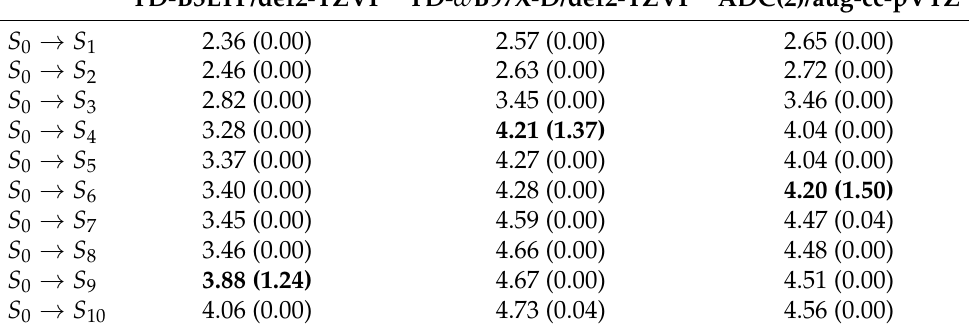
Table 3. Vertical excitation energies in eV and oscillator strengths (in parentheses) of the lowest ten electronic transitions of the cofacial π -stacked azobenzene dimer d = 3.5 Å calculated with TD-B3LYP/def2-TZVP, TD- ω B97X-D/def2-TZVP, and ADC(2)/aug-cc-pVTZ. The dimer geometry is constructed from the B3LYP/def2-TZVP optimized monomer geometry. The brightest transitions are shown in bold.